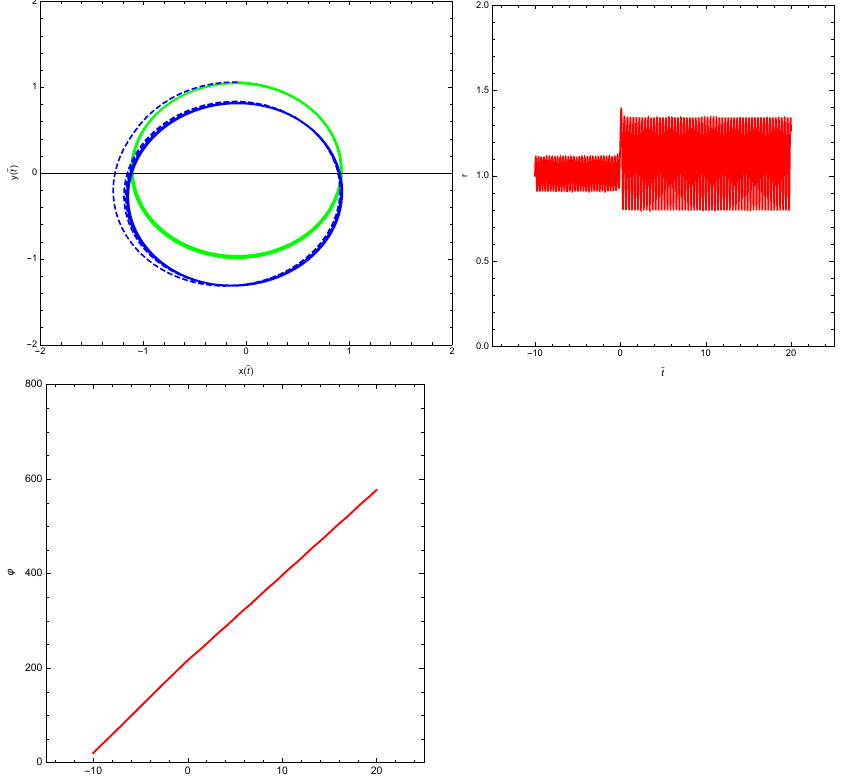
Figure 1. Upper left panel : Point particle trajectories in the Cartesian plane before the pressure singularity (green curves) during the pressure singularity and after the pressure singularity (blue curves). Upper right panel : The functional dependence of the radial coordinate ¯ r ( t ) with respect to the rescaled cosmic time. Bottom Panel : the functional dependence of ϕ ( t ) with respect to the cosmic